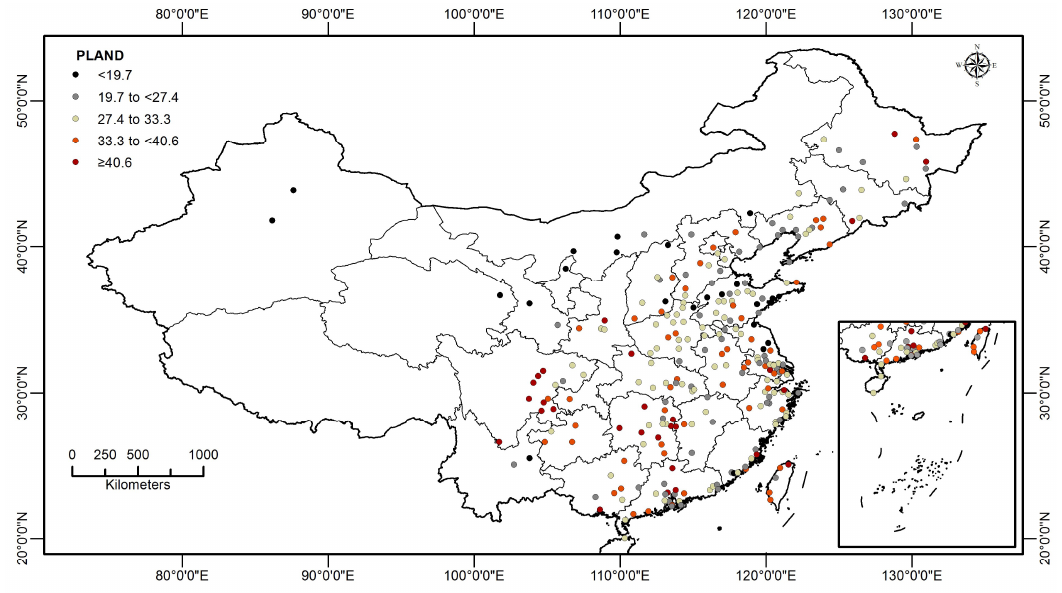
Figure 3. PLAND (percentage of landscape, %) values of UGS in 262 cities.